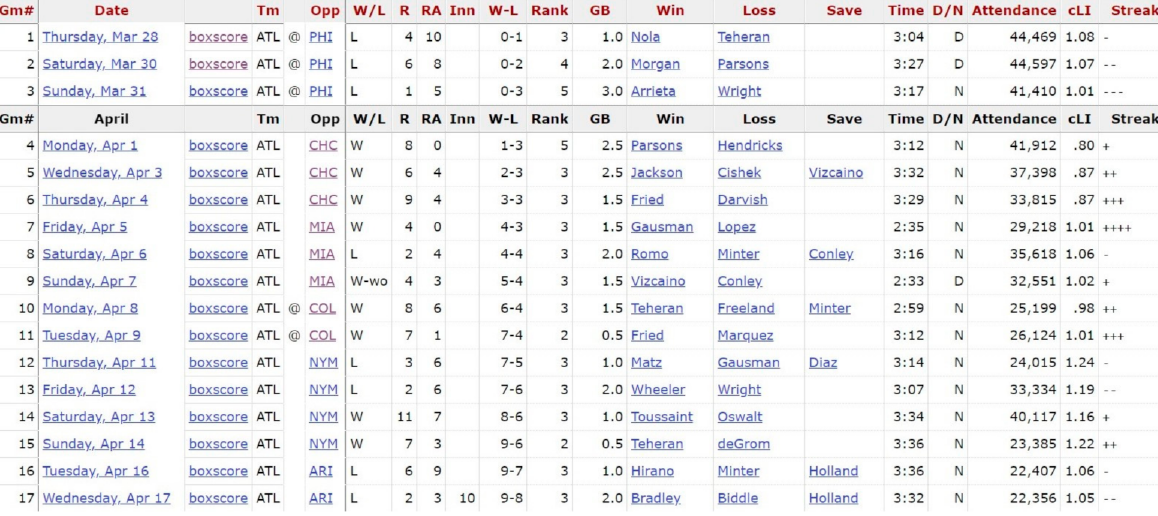
Figure 4. Related